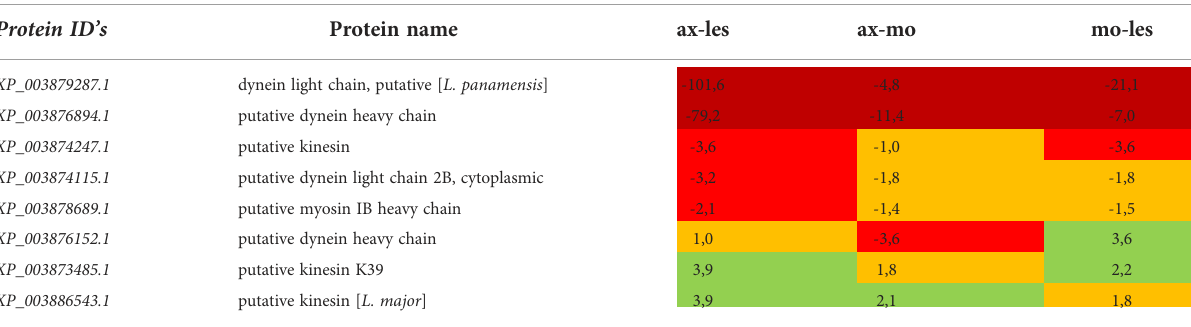
TABLE 7 Molecular motors identi fi ed in all 3 comparisons that differ by at least 2-fold (T-test signi fi cant) between individual amastigote types. Molecular motors